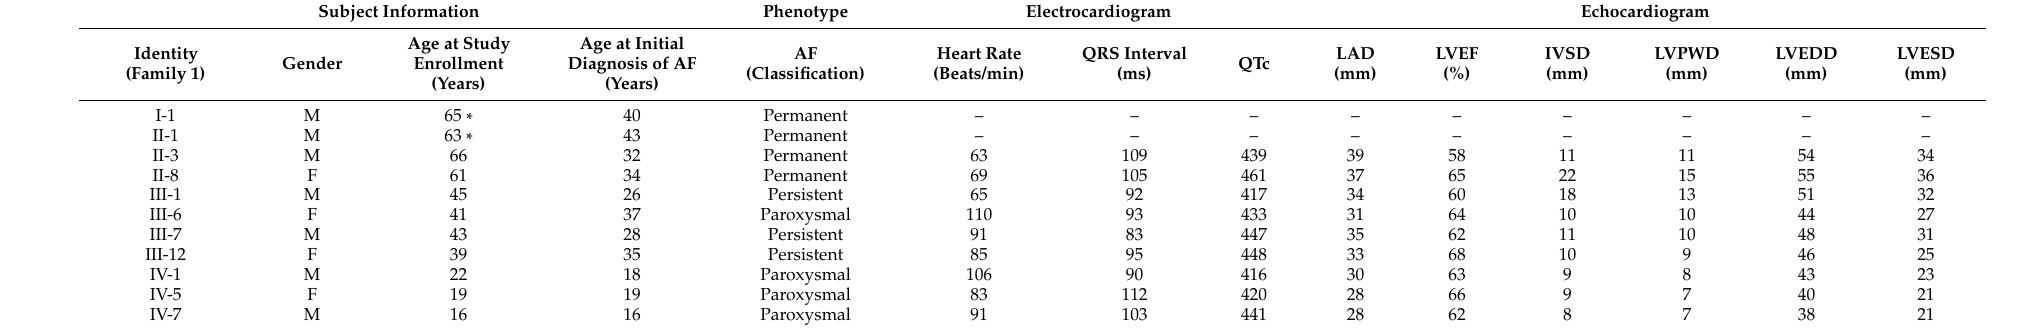
Table 1. Clinical characteristics of pedigree members affected by atrial fibrillation.